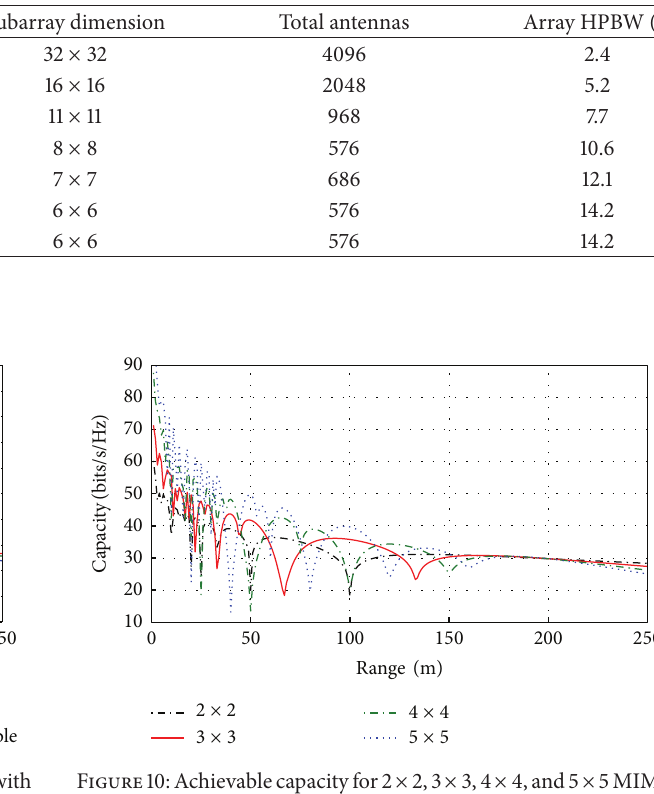
Table 3: Array gain reduction by increasing the number of MIMO nodes (2 × 2 set as reference).